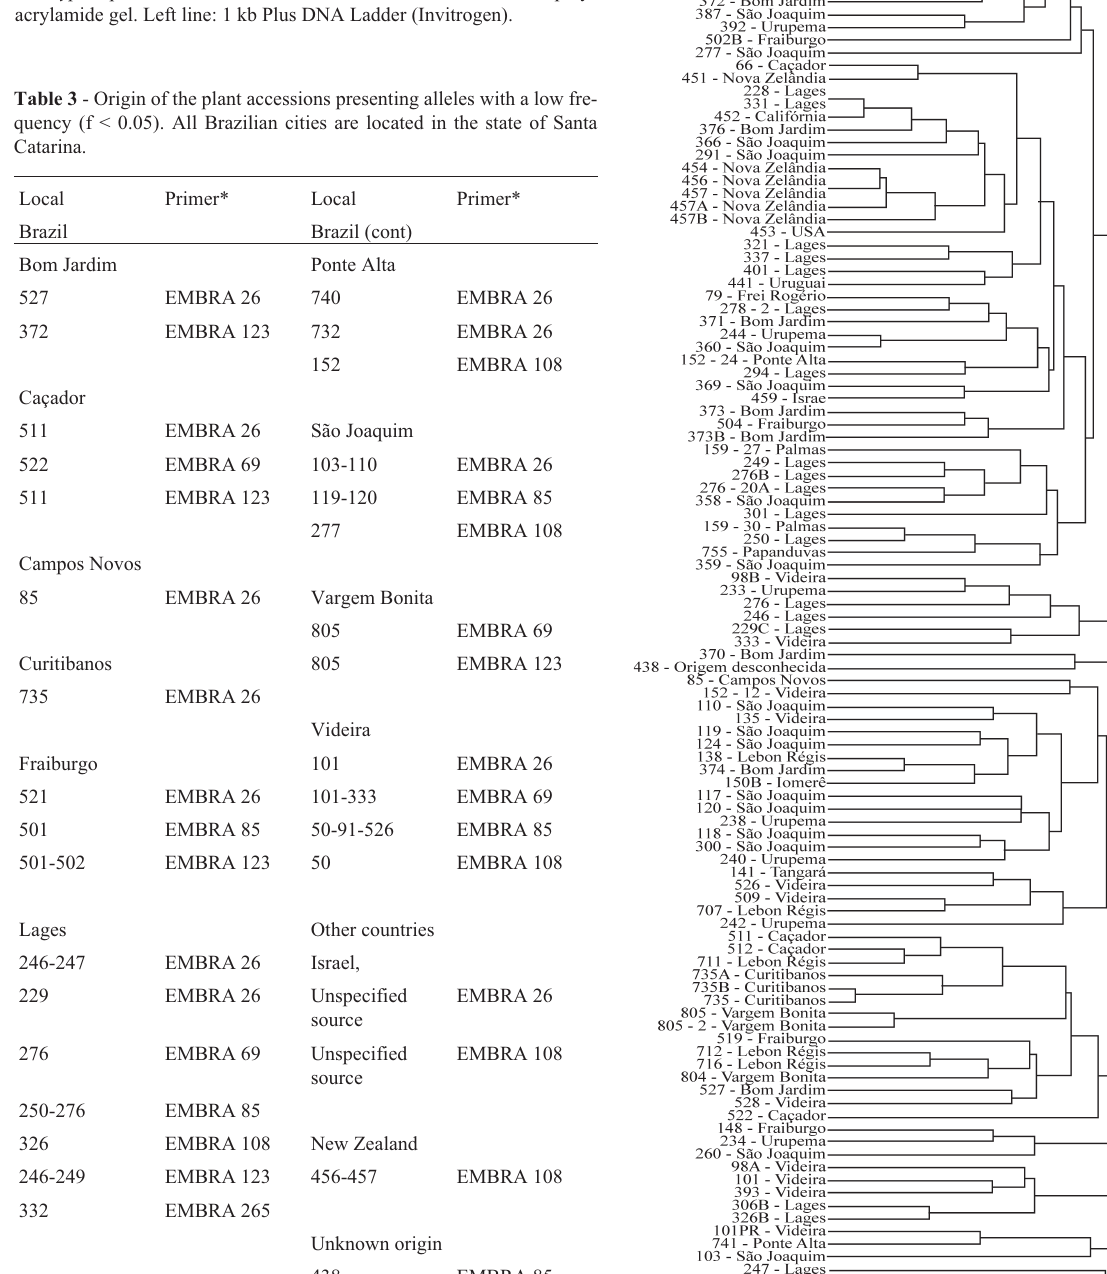
Figure 1 - Profile of the PCR products of 21 Acca sellowiana accessions from the Active Germoplasm Bank. The products were amplified by the